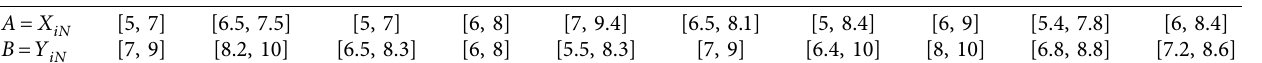
Table 1: The neutrosophic